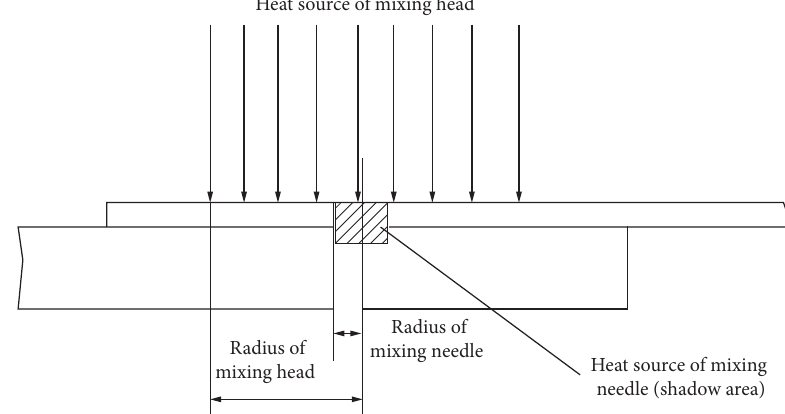
Figure 9: The heat source model.